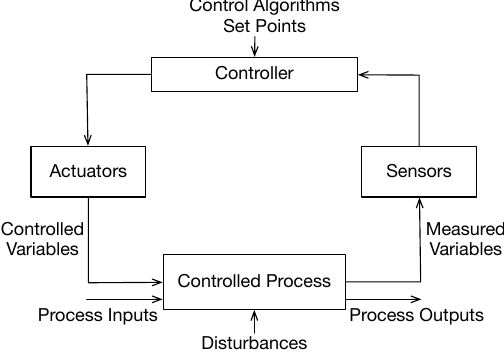
Figure 1. A standard control